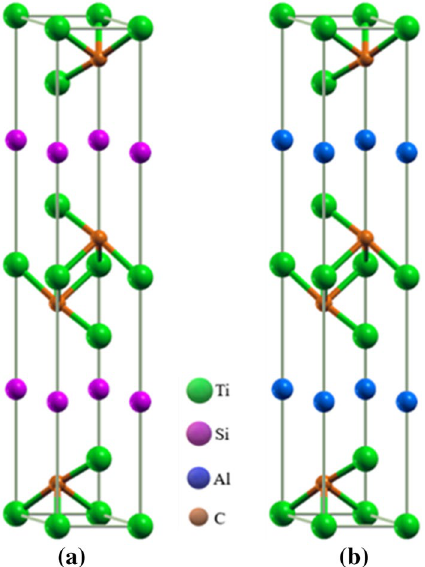
Figure 1. Crystal structure of ( a ) Ti 3 AlC 2 , ( b ) Ti 3 SiC 2 MAX phase